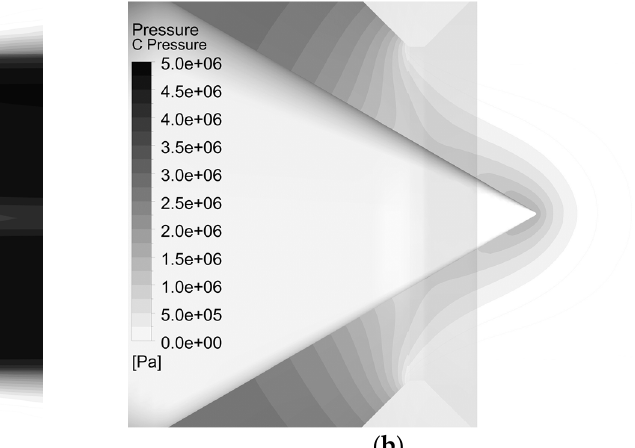
Figure 10. Comparison of the relative headloss . 3.2. Results of the Runner Simulation The results of the three runner simulations, based on different runner geometries, are analysed with a special procedure. For the analysis of the turbine performance in general,